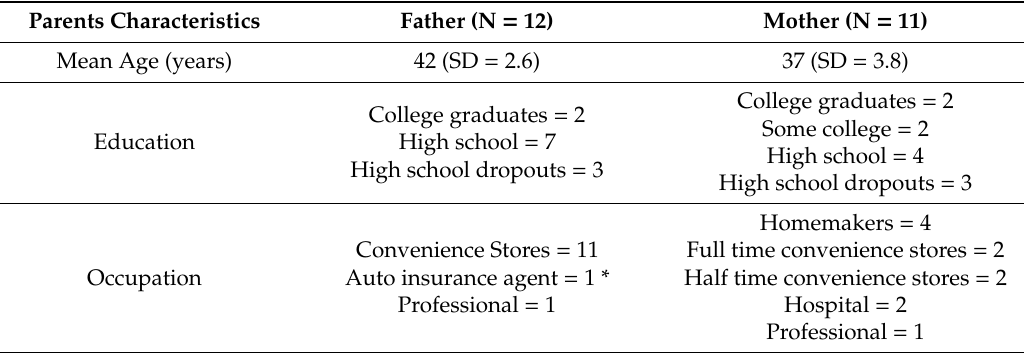
Table 1. Demographics of the